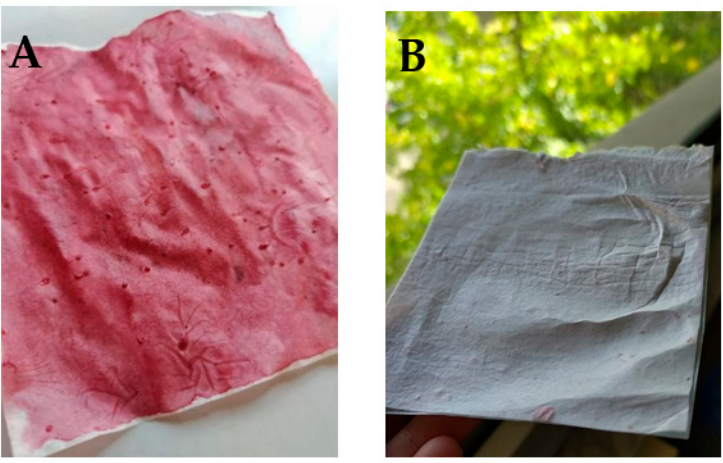
Figure 5. Image of created active pads: pad F 0 ( A ) and pad F 1 ( B